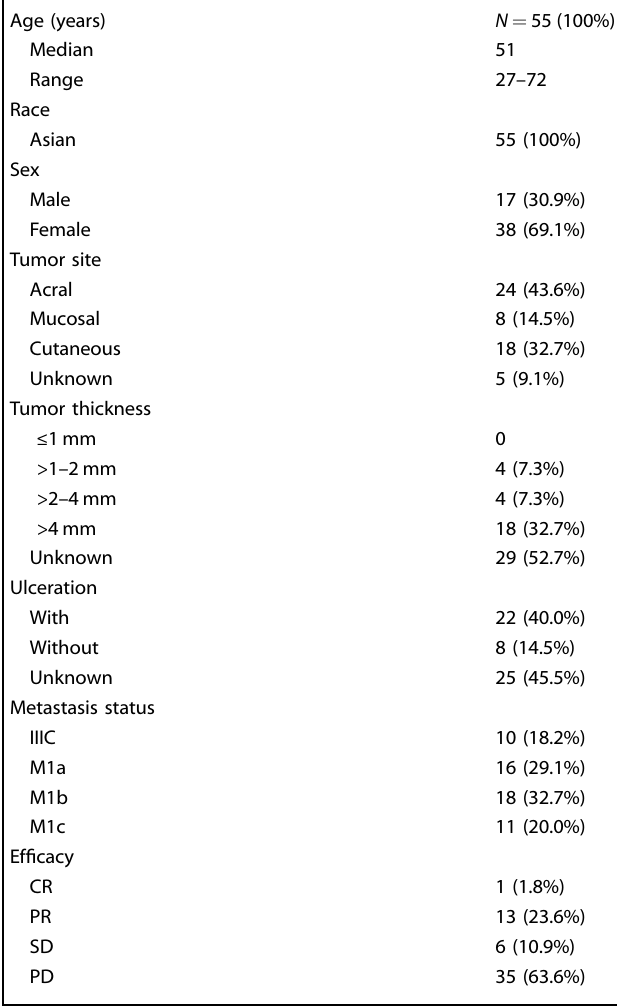
Table 3. Patient